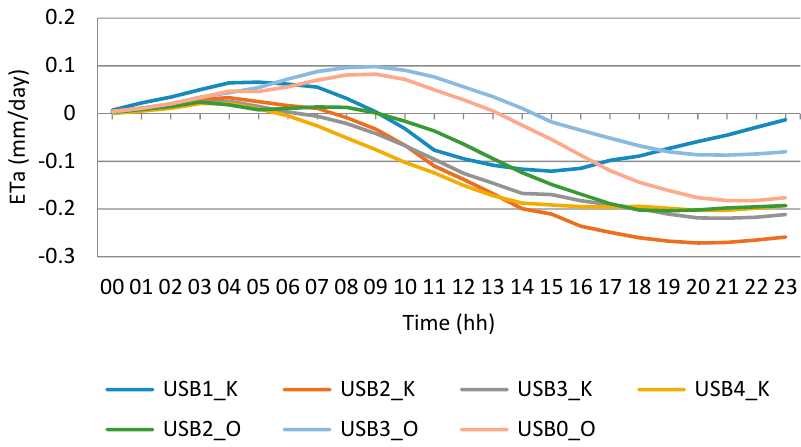
Figure 1. Extremely low actual evapotranspiration (ET a ) of extensive green roofs (EGRs) during a dry and hot period in 2018. The measurements were recorded with by weighting a small scale lysimeter on the experimental green roof of the University of Applied Sciences in Neubrandenburg, Germany. By measuring the high-density weight, we also measured the condensation on the leaves and substrate. (USB1_K = 10.00 cm gravel roof – USB2_K – USB4_K = 16.10 cm; USB0_O = 8.88 cm; USB2_O = 14.88 cm; USB2_O = 20.88